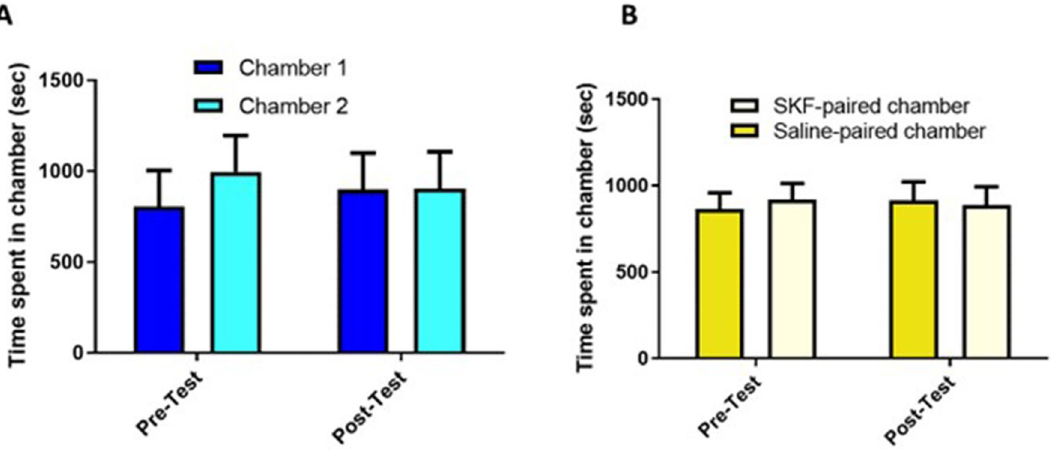
Figure 2. Time spent in the conditioning chambers during the pre and postconditioning tests in the saline- saline ( A ) and SKF-saline ( B ) groups. ( A ) There were no significant changes in the time spent in chamber 1 and 2 during all tested phases (n = 6). ( B ) There were no significant changes in the time spent in the saline-paired chamber compared to the SKF-paired chamber during the pre and postconditioning tests (n = 8). Values are reported as means ± standard error of the